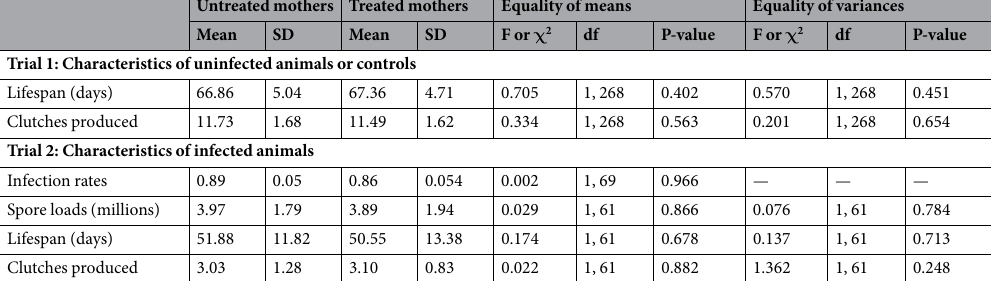
Table 3. The influence of the hormone treatment on the fitness characteristics of the following offspring generation. Equality of means was assessed using a least-squares linear model in the case of lifespan and spore loads, and a generalised linear model for the number of clutches produced (Poisson distribution, log link function) and infection rates (Binomial distribution, logit link function). Where appropriate, Levene’s test was used to assess homogeneity of variances between the offspring of untreated and treated mothers. All measures were estimated using a single genotype of both D. manga (HU-HO-2) and P. ramosa (C14), following the same basic infection process outlined in this